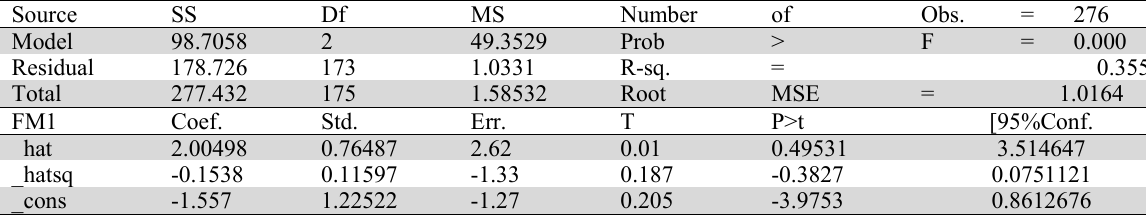
Model Specification for external financing of business projects (FM1)